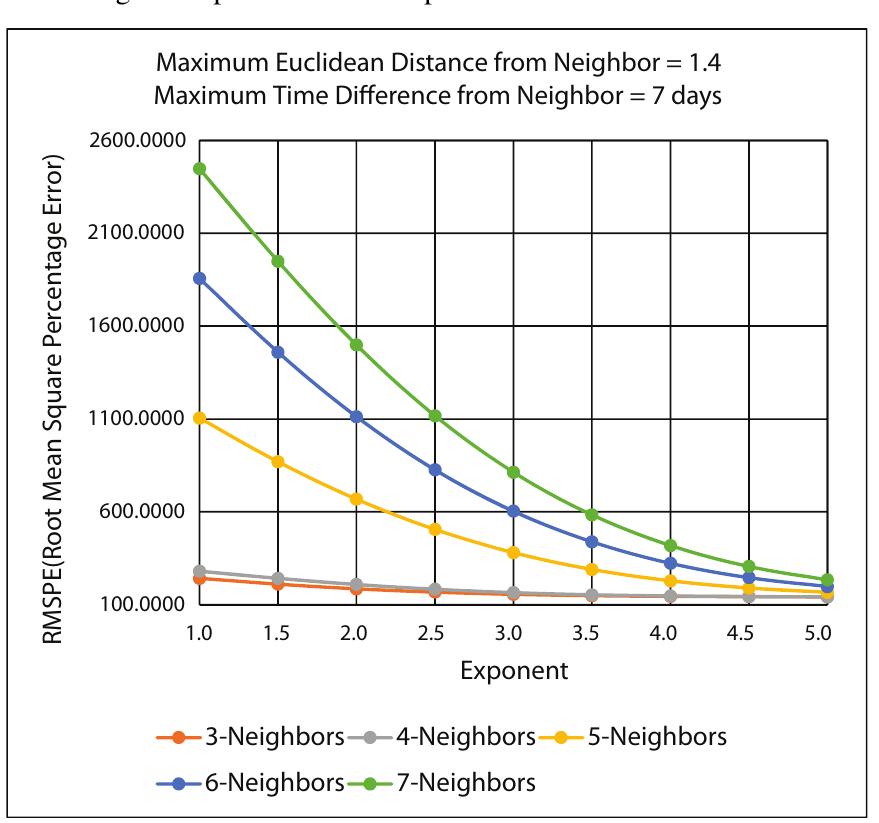
Figure 19. RMSPE (root mean square percentage error) LOOCV results for the various 45 IDW methods using the improved IDW interpolation.